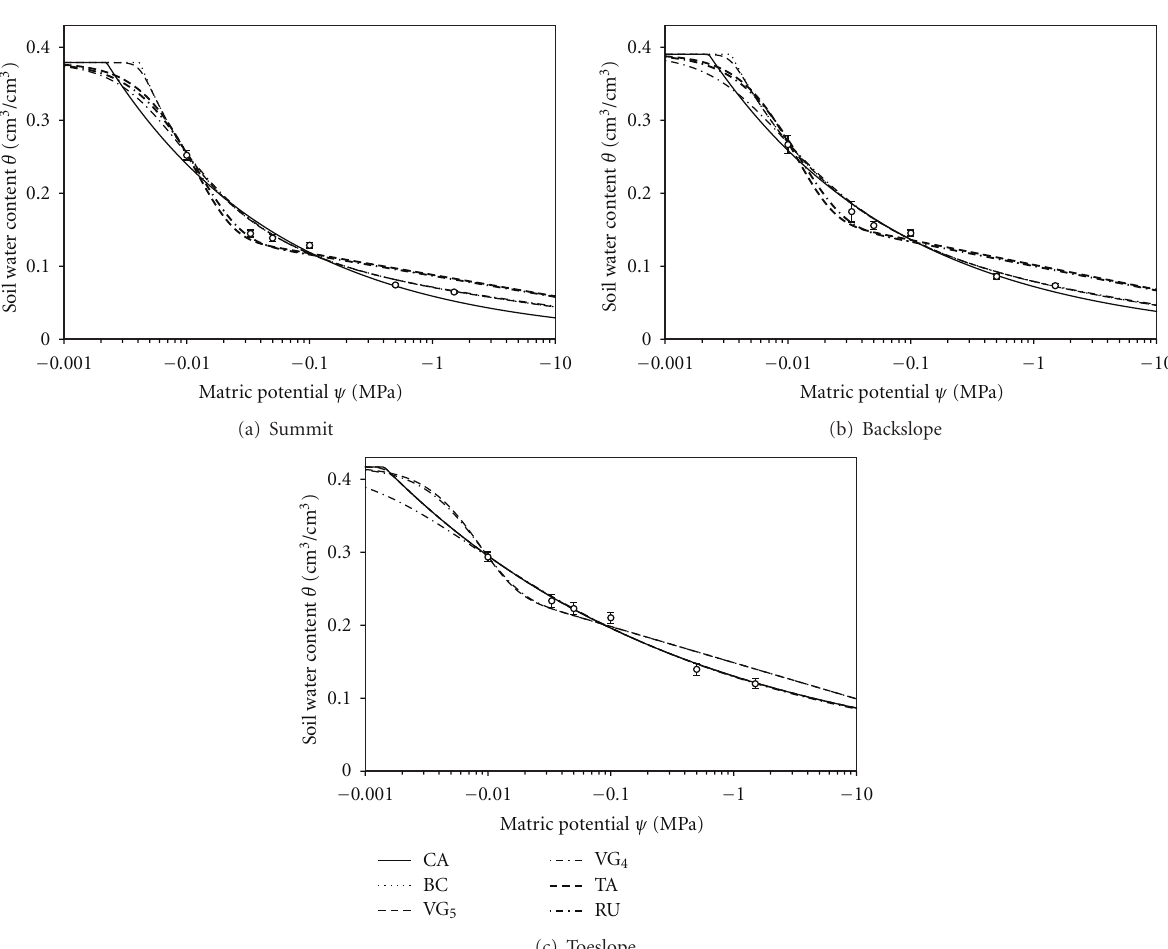
Figure 2: Fitted SWRC for soil water contents ( θ ) at soil matric potentials ( ψ ) for the (a) summit, (b) backslope, and (c) toeslope positions averaged across two hillslopes using the Campbell (CA) model with absent θ r parameter, and Brooks-Corey (BC), five- and four-parameter van Genuchten (VG 5 and VG 4 ), Tani (TA), and Russo (RU) models with θ r modified by a logarithmic equation describing the adsorption of water on soil in the dry range of the retention curve. Error bars are SE for six water retention